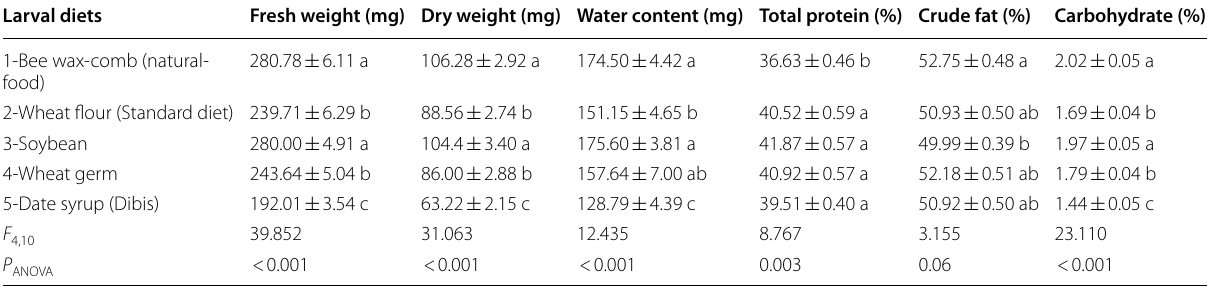
Means SE sharing the same small letters in the same columns are statistically insignificant ( p > 0.05) ±